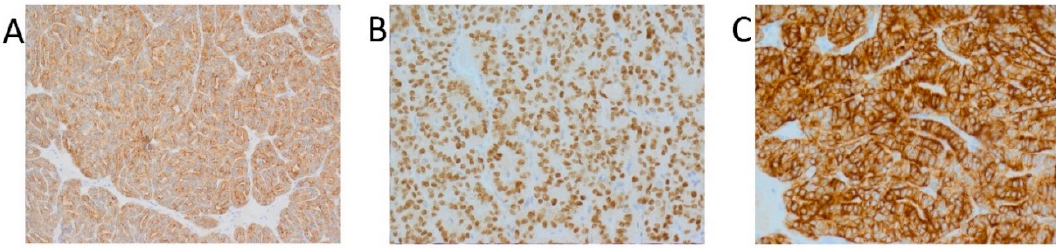
Figure 3. Immunohistochemical (IHC) staining of PTC in struma ovarii ( A ) 100 × magnification; immunoreactivity for thyroglobulin, ( B ) 200 × magnification; immunoreactivity for TTF-1, ( C ) 200 × magnification; immunoreactivity for CK19. Diagnostics 2020 , 10 , 45